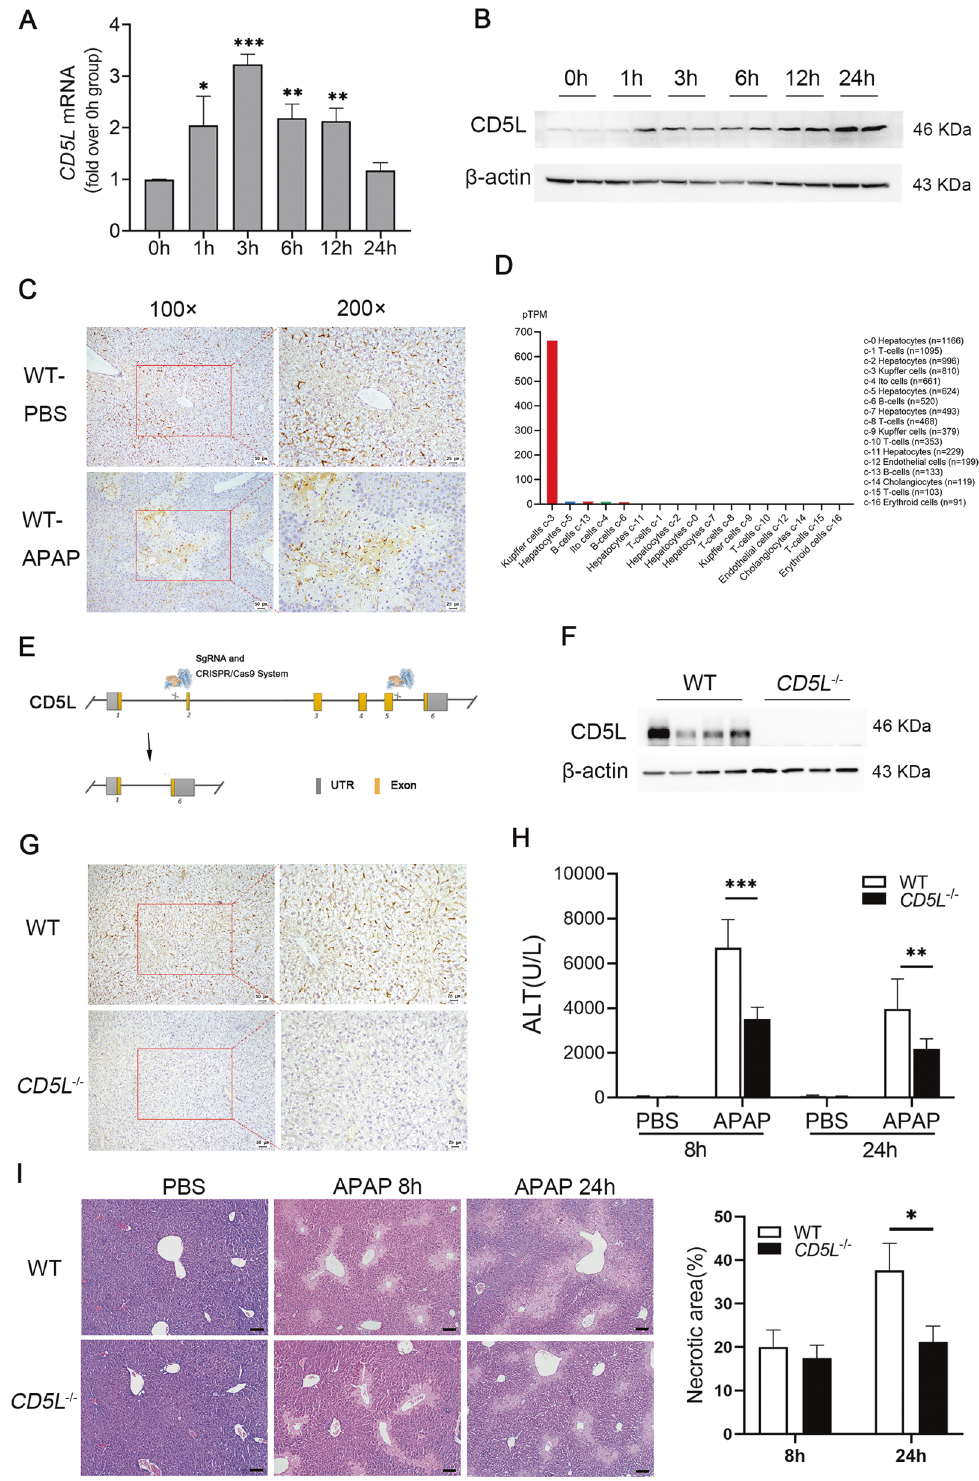
Fig. 1 CD5L de fi ciency alleviates APAP-induced liver injury in mice. APAP was intraperitoneally injected into wild-type (WT) mice ( n = 5 for each time point) at 300 mg/kg, and the CD5L level in the liver at speci fi ed time point was detected by A q-PCR and B western blotting; C Immunohistochemical staining of CD5L in liver sections of WT ( n = 4 for each group) treated with PBS or APAP for 24 h, representative images are shown; D The expression of CD5L in human liver tissue (www.proteinatlas.org); E The diagram of CRISP/Cas9 CD5L knockout strategy; F The expression of CD5L protein in the liver of WT and CD5L -/- mice was detected by western blotting; G Immunohistochemical staining of CD5L in liver sections of WT or CD5L − / − mice ( n = 4 for each group), representative images are shown; H , I Serum ALT and liver H&E staining at 8 h and 24 h after PBS or APAP injection in mice ( n = 10 for each group). Necrotic area was measured by Image J. Representative images are shown. Scale: 100 μ m. The results are presented as means ± SD of at least three independent experiments. * P < 0.05; ** P < 0.01; *** P < 0.001. Cell Death Discovery (2021)